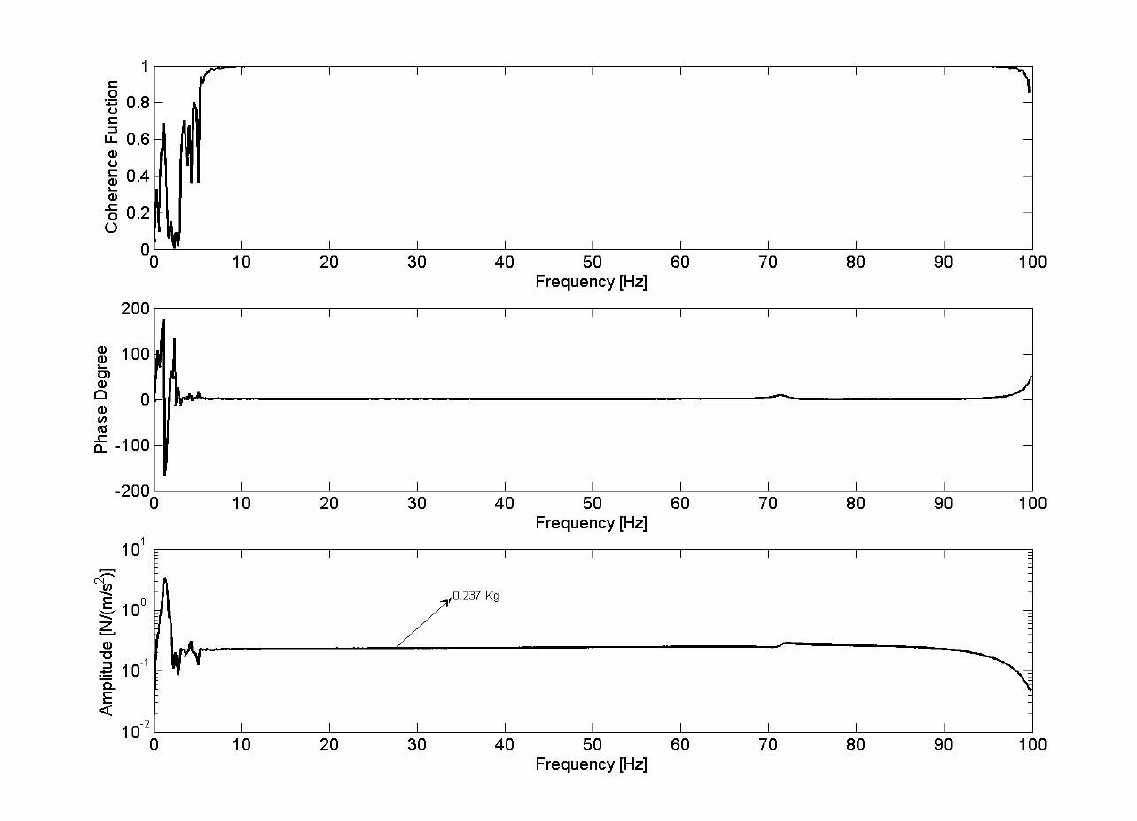
Fig. 10. Transfer function between the signals from load cell 02 and the accelerometer 01.